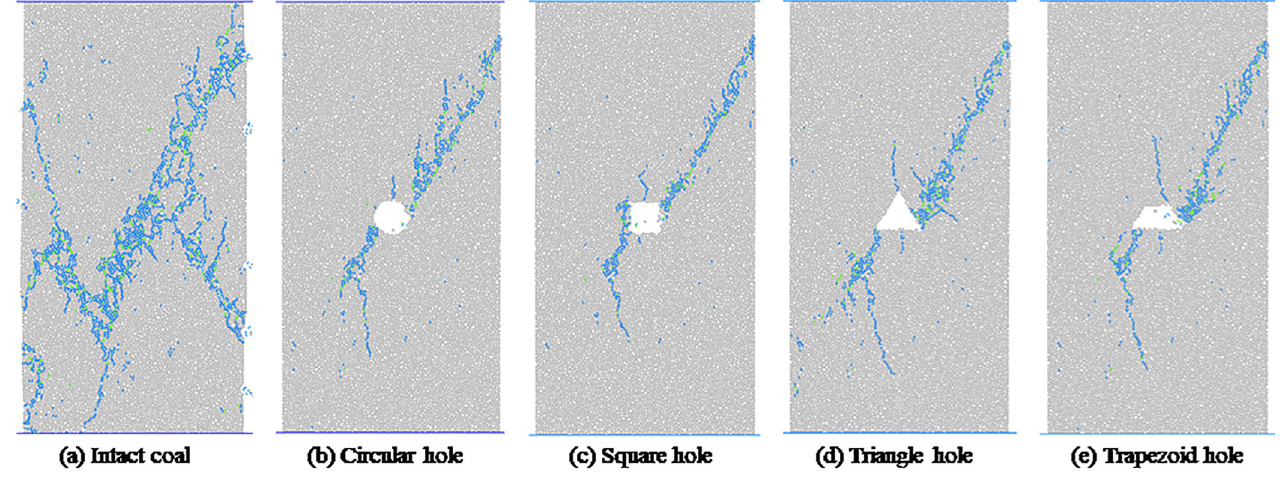
Fig 9. Simulation results of macroscopic failure modes of coal and rocks with hole defects of different shapes.